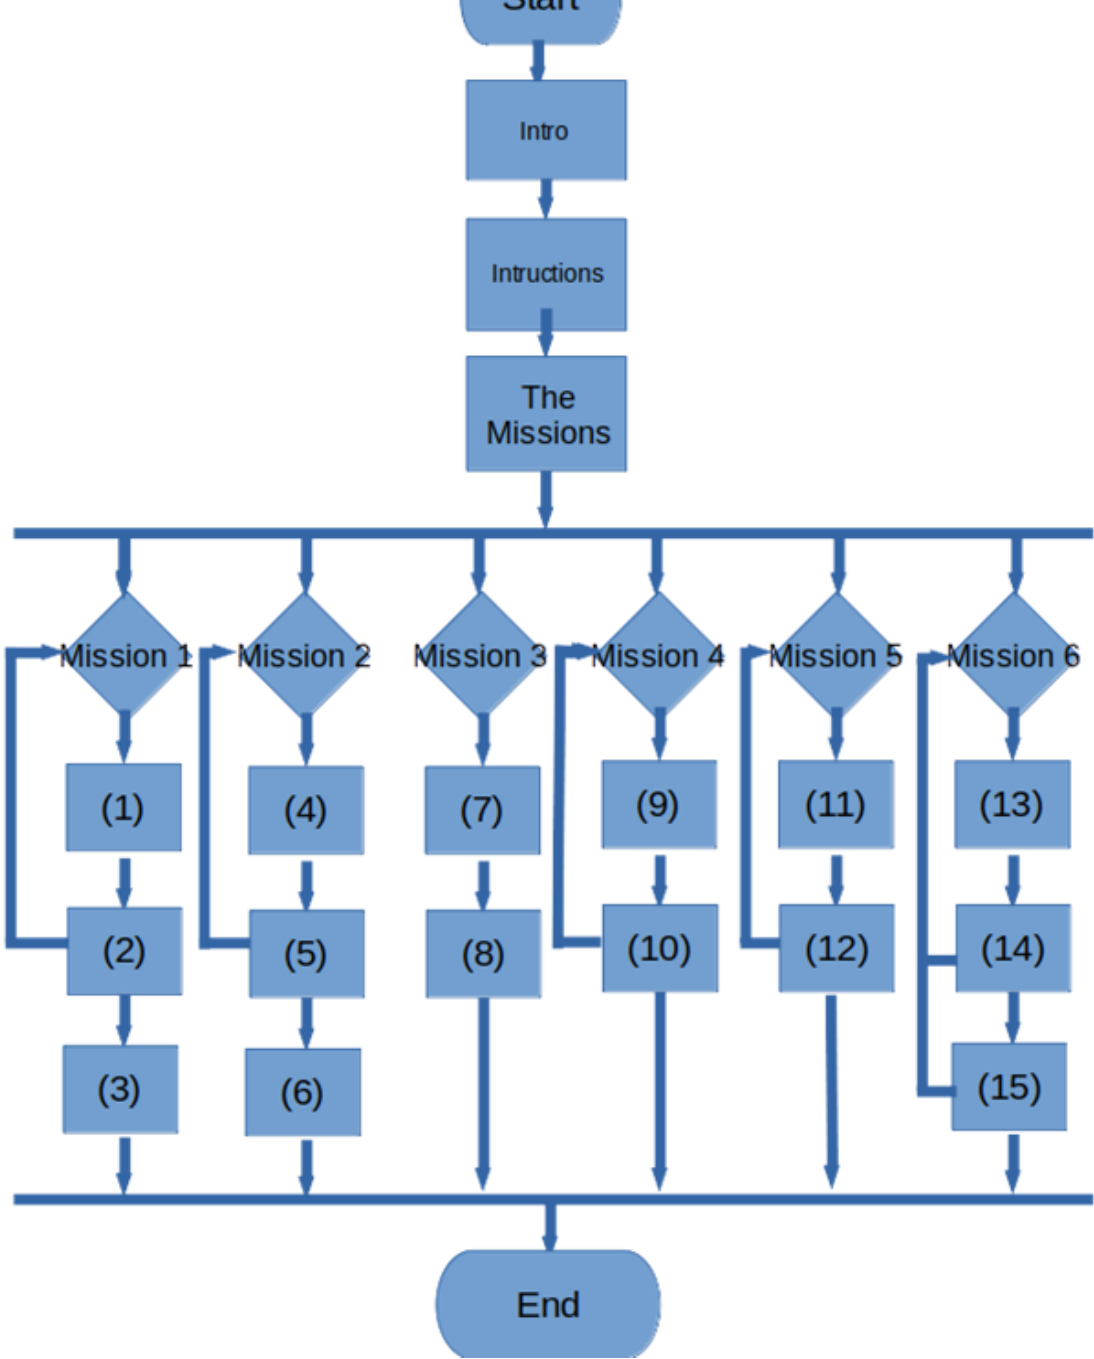
Figure A1. Screens where the student guess or fail the